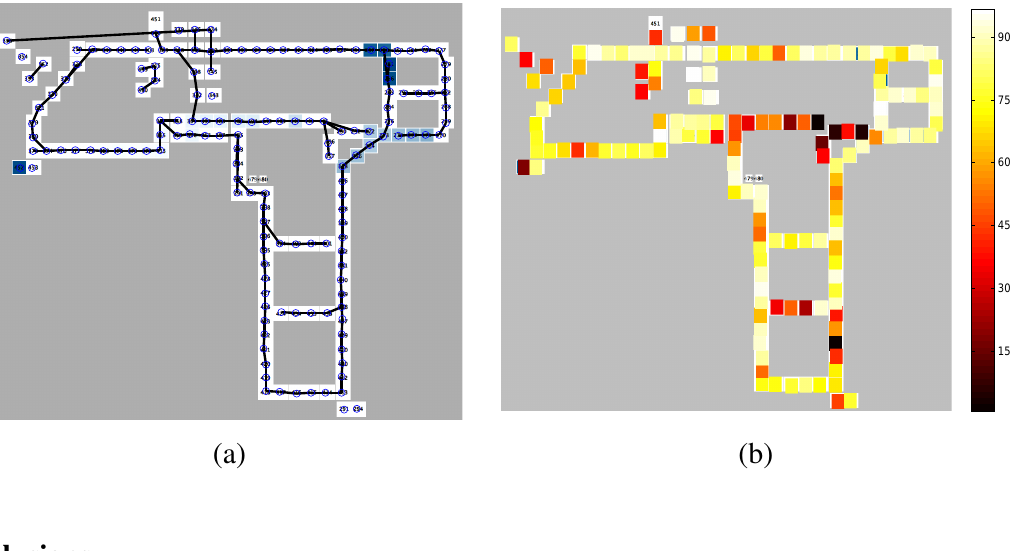
Figure 5. (a) Automatically generated Voronoi graph of the MERL lab, superposed on the layout. The circles indicate approximate sensor locations, and the connection links indicate the elementary patterns. (b) Predictability of the next sensor event, given the activation of a sensor. Activation of sensors shown with light colours is a good predictor of the next related